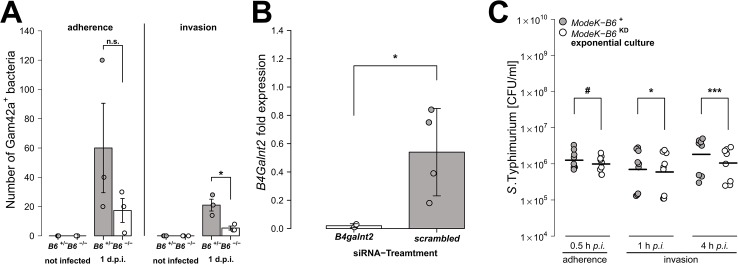
Epithelial B4galnt2-expression increases invasion by S. Typhimurium.(A) Carnoy’s fixed cecal sections were stained by FISH (Gam42a probe) to visualize bacteria. Measurement of Salmonella adherence (t
2.286 = -1.349, P = 0.2954, unpaired t-test) and mucosa invasion (t
2.430 = -3.681, P = 0.0491; bacterial counts in 10 high power fields per individual, N = 3; unpaired t-test). (B) B4galnt2 expression in Mode-K cells after transfection with B4galnt2 specific siRNA and scrambled siRNA relative to untreated cells (t
3.025 = -3.3601, P = 0.0432; unpaired t-test). (C) Salmonella invasion of Mode-K cell cultures transfected with B4galnt2 specific and scrambled siRNA, infected with S. Typhimurium. There is no significant effect of B4galnt2 expression for adhesion of the bacteria to Mode-K cells (0.5 h: F
1,14 = 3.133, P = 0.0985; LMM with experiment as random factor), while invasion of S. Typhimurium into Mode-K cells expressing B4galnt2 was slightly better than into cells with B4galnt2 knockdown (1 h: F
1,14 = 7.644, P = 0.0152, 4 h: F
1,14 = 26.336, P = 0.0002; LMM with experiment as random factor; # P < 0.100, * P < 0.050, ** P < 0.010, *** P < 0.001; error bars indicate SEM).